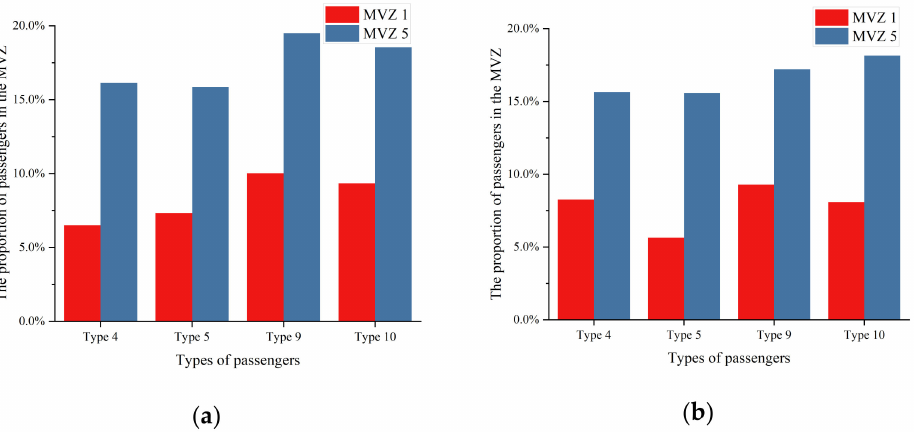
Figure 14. The MVZs of the first 10% of arriving passengers under night scenarios; ( a ) the night- individual scenario. ( b ) the night-group